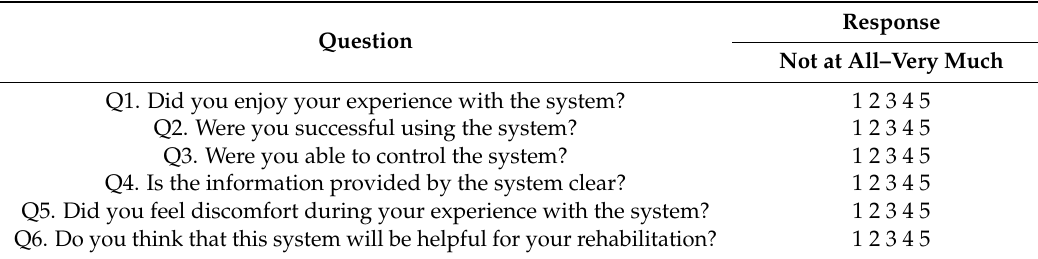
Table 1. The USEQ (User Satisfaction Evaluation